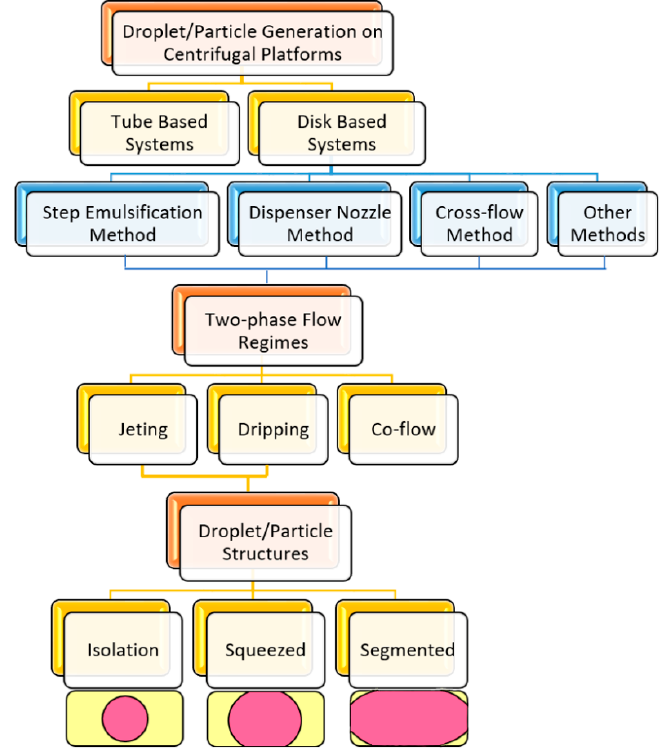
Figure 1. Different methods of droplet/particle generation on centrifugal microfluidic platforms. Figure 1. Di ff erent methods of droplet / particle generation on centrifugal microfluidic